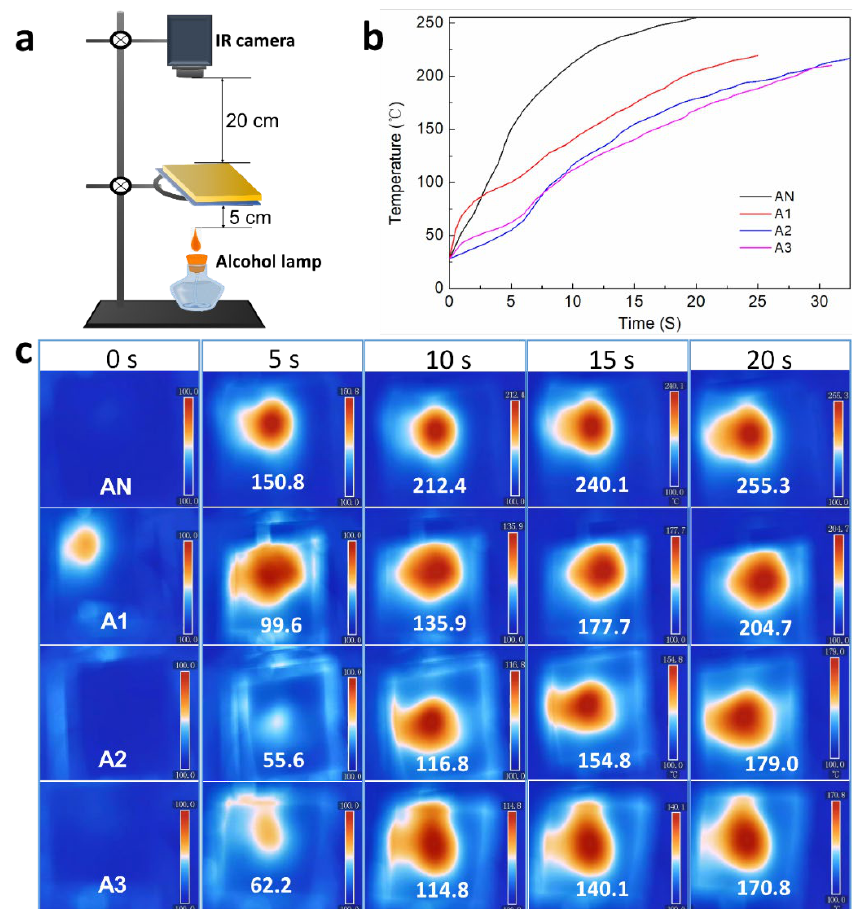
Figure 6. Thermal insulation performance . ( a ) Homemade setup for determining the flammability of AN. ( b ) Comparison of the temperature change of AN before and after coating treatment. ( c ) Temperature determined by the infrared camera for AN before and after coating treatment above an alcohol lamp. The sample thickness was 2.8 mm.